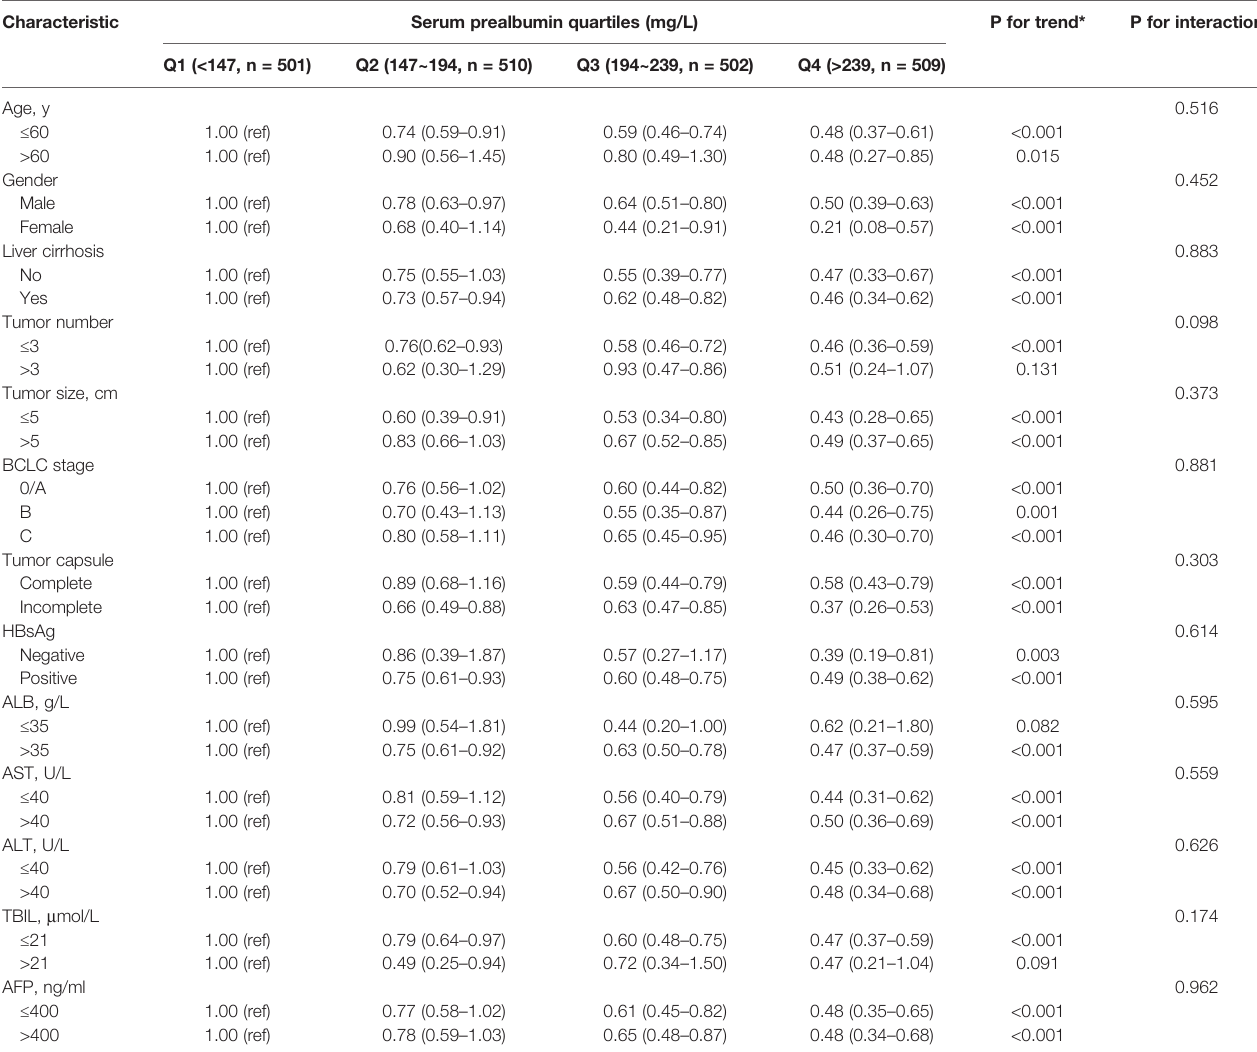
TABLE 4 | Strati fi ed associations between serum prealbumin and all-cause mortality. Characteristic Serum prealbumin quartiles